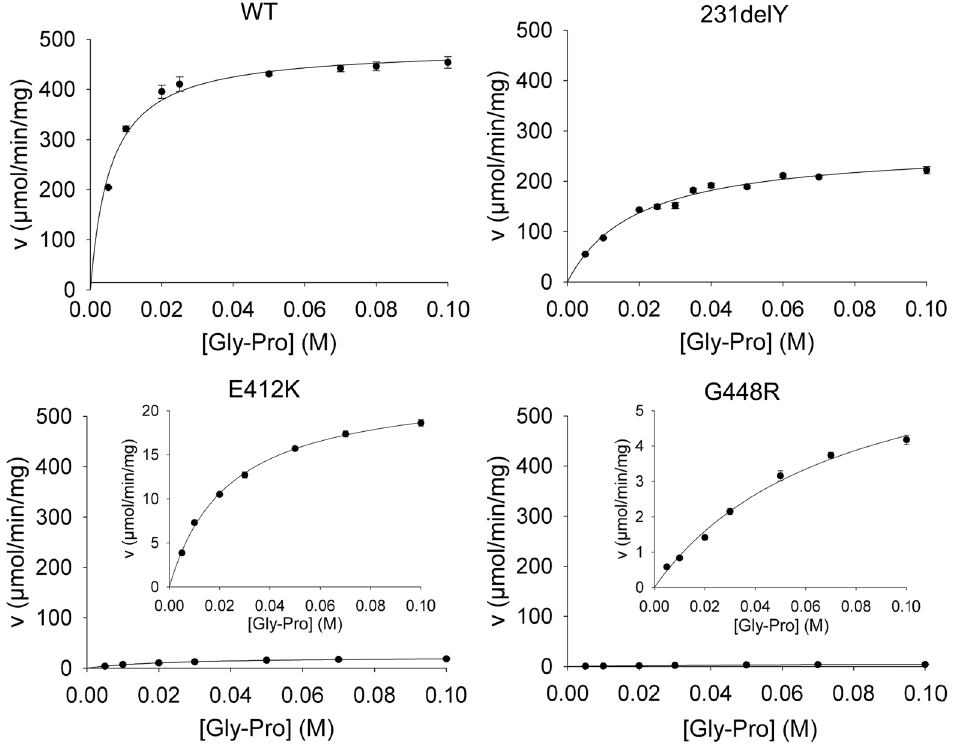
Figure 2. Kinetic analyses of hRecProl-WT and its pathological variants. Michaelis-Menten plots obtained using Gly-Pro as substrate. The graphs of hRecProl-E412 and hRecProl-G448 were magnified in the insets for clarity.